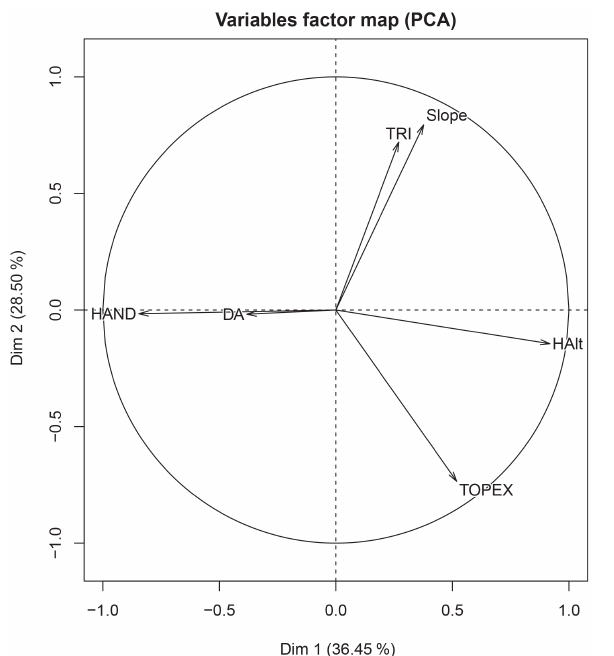
Figure 3. The observed gap size frequency distributions modeled as a power law function with λ = 2 .